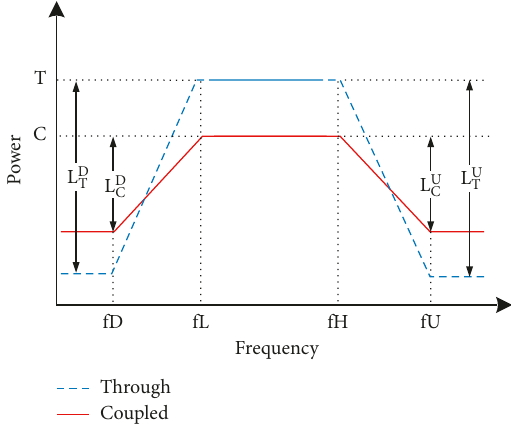
Figure 8: Frequency response of couple port and through port. Table 1: Values of (9) for design 3dB ATRD coupler has been described in Example 1.